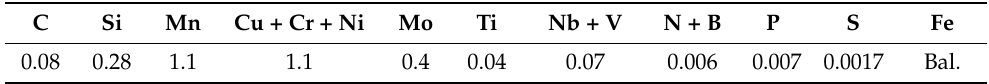
Table 1. Chemical composition of the experimental steel